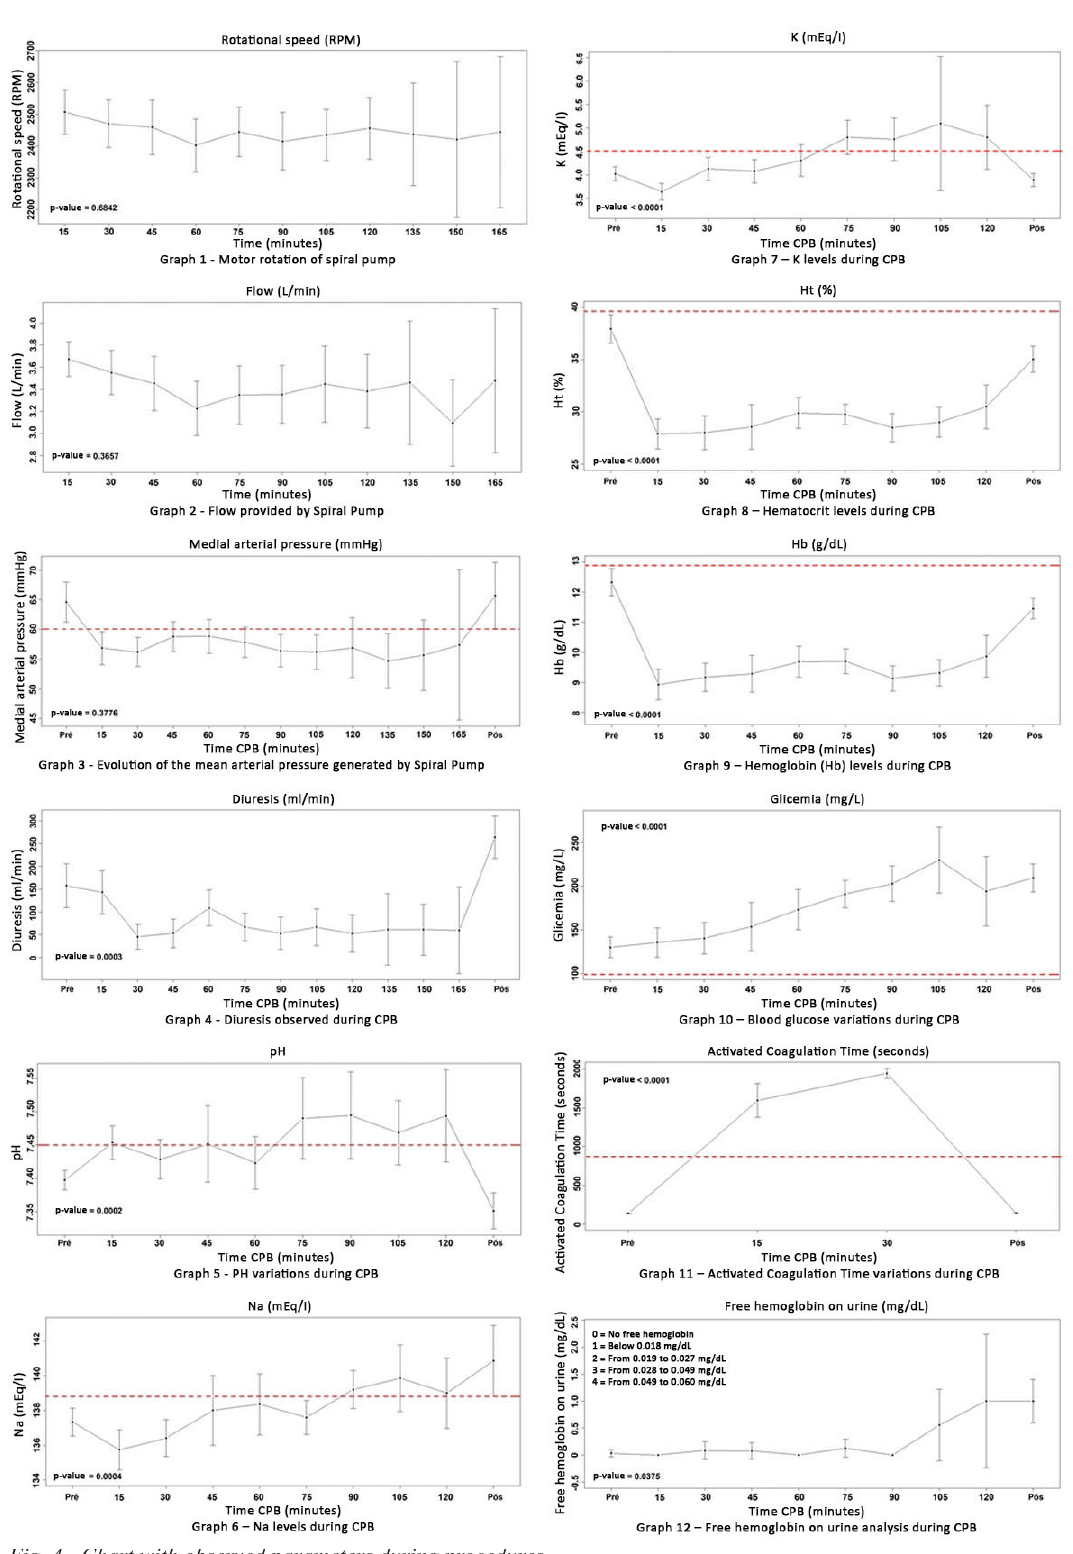
Fig. 4 - Chart with observed parameters during